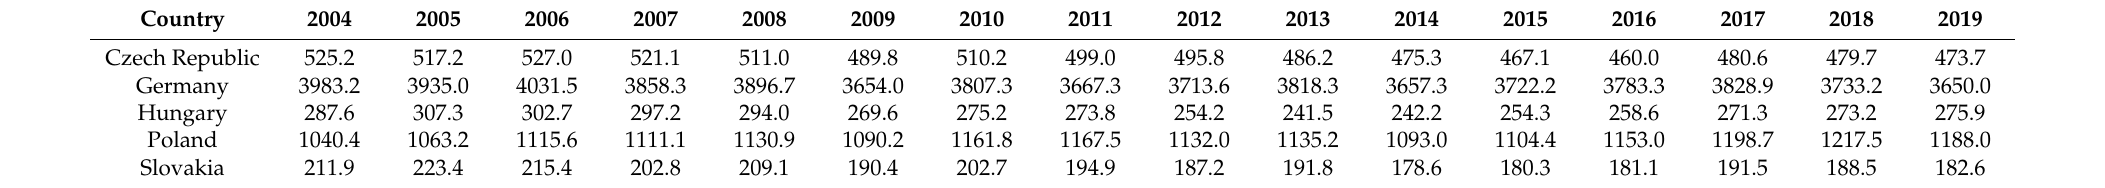
Table 1. Primary energy: Consumption [TWh].